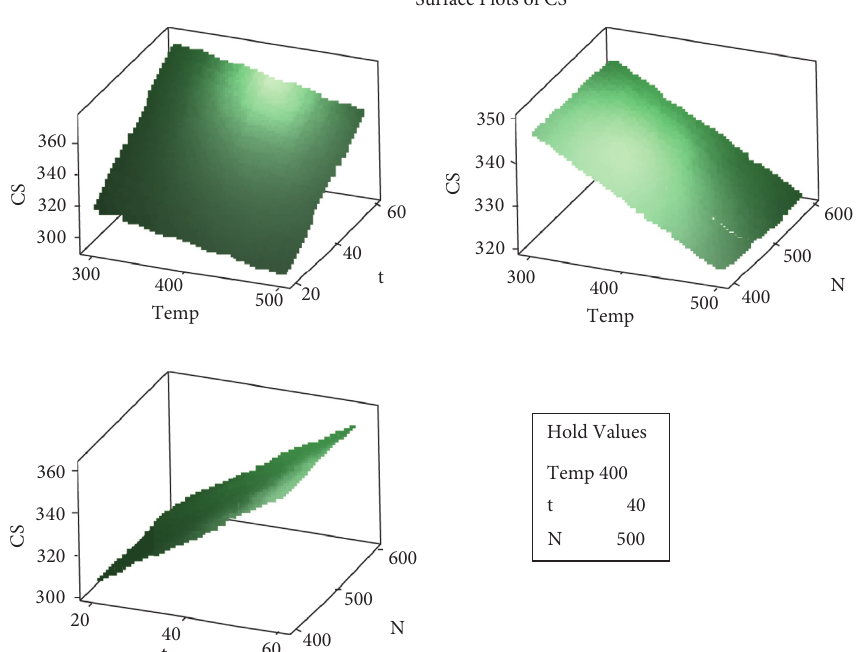
Figure 9: Comparison of the compressive strength using surface plots (temp: temperature in ° C; t : time in sec; N : stir speed in